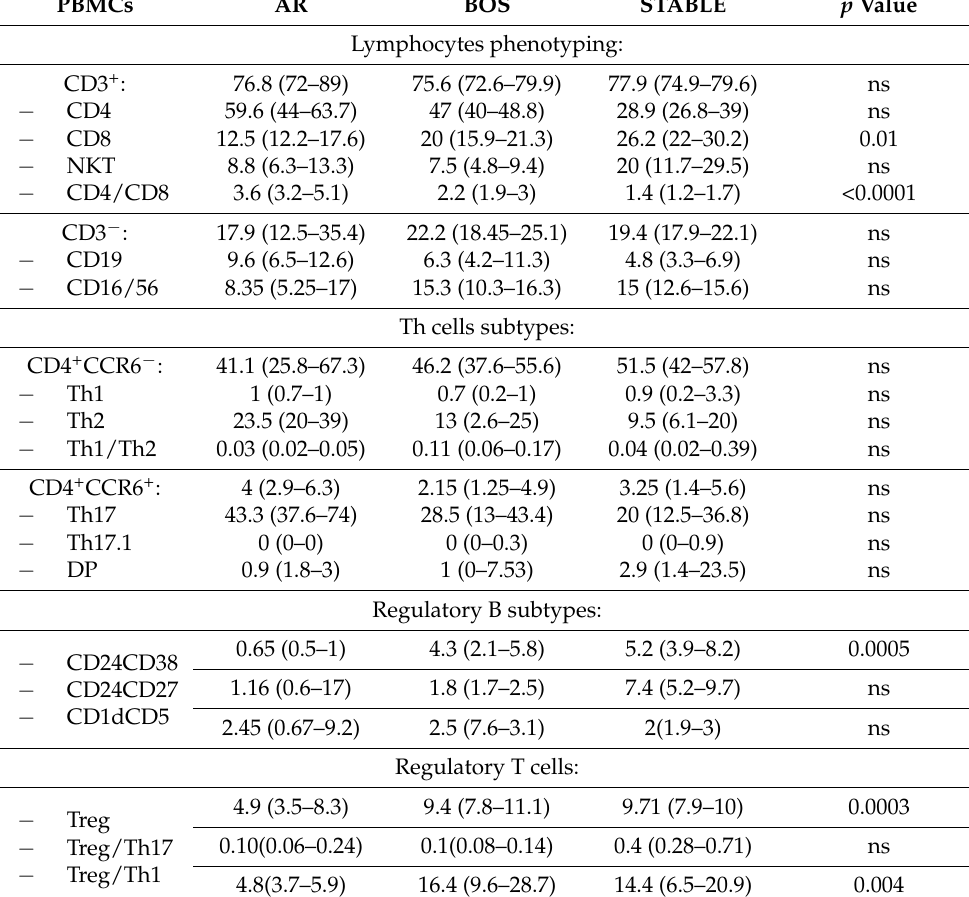
Table 2. Cellular analysis on peripheral blood mononuclear cells (PBMCs) in AR, BOS and Sta- ble